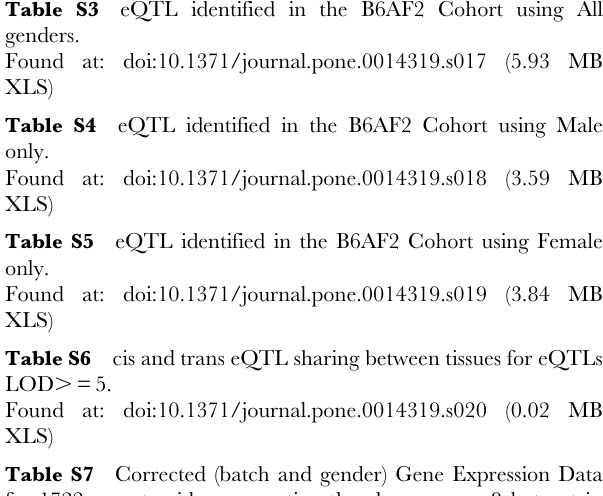
Table S12 Body Composition data by qNMR for Akr1b8-/-, Emr1-/-, and Rgs2-/- and littermate controls.